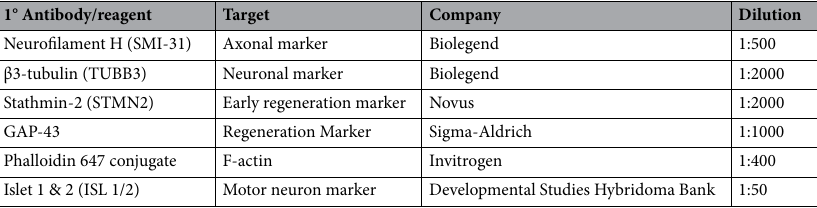
Table 1. Antibodies/Reagent used for immunofluorescence